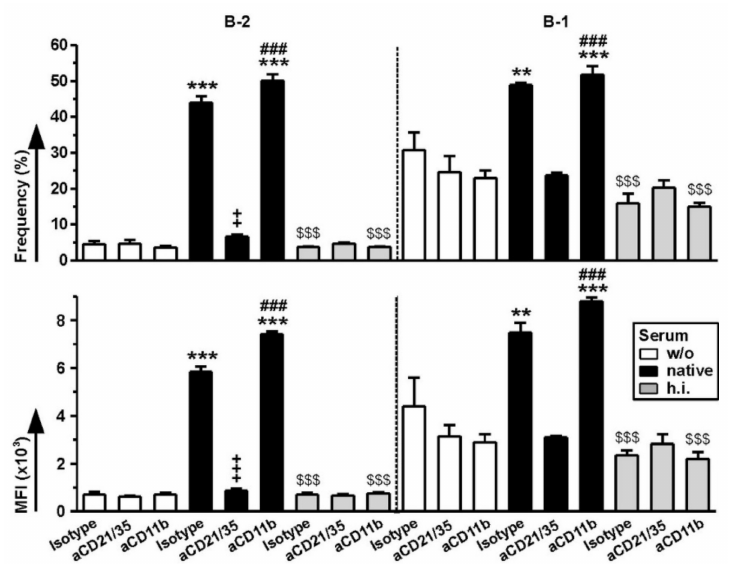
Figure 7. B-1 cells engage complement-opsonized FeO-DEX via CR1/2, but not CR3. Spleen cells were pretreated in parallel with antagonistic anti-CD21/CD35 (CR1/2), anti-CD11b (CR3) and an according isotype control antibody (each 5 µ g/mL), followed by incubation with differentially pretreated FeO-DEX (left untreated (w/o), pretreated with native or heat-inactivated (h.i.) serum) applied 45 min later. Frequencies of Cy5 + cells (upper panel) and MFI of Cy5 (lower panel) of B-2 (left panel) and B-1 (right panel) cells, identified as CD11b − CD19 + (B-2 cells) and CD11b + CD19 + (B-1 cells) were assessed 3 h after the onset of incubation with FeO-DEX (mean ± SEM of 3 experiments). Statistical differences * versus w/o and $ versus native serum group (treated with the same antibody), + versus isotype and # versus aCD21/35 (within same group) are indicated (one-way ANOVA, Tukey’s test). * ,+,# p < 0.05, ** ,++,## p < 0.01, *** ,+++,###,$$$ p <